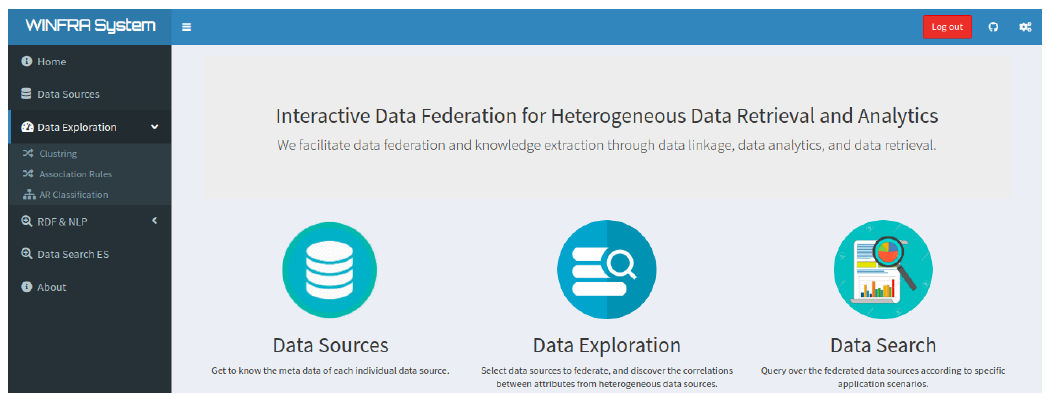
Figure 2. User interface of the WINFRA